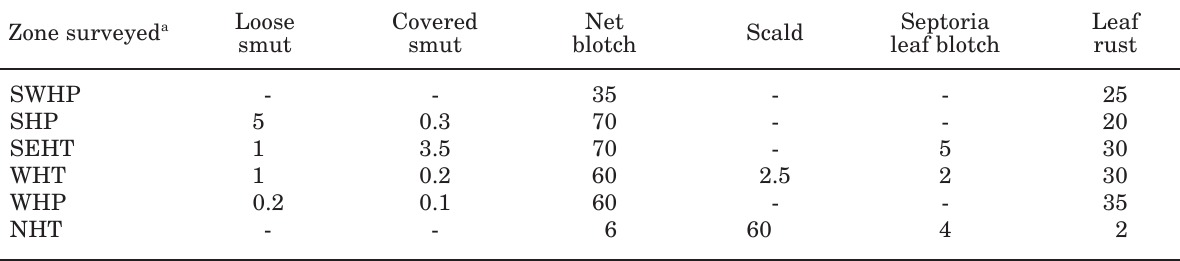
Table 5. Average incidence (%) of barley diseases in fields in Eritrea in 2001. Zone surveyed